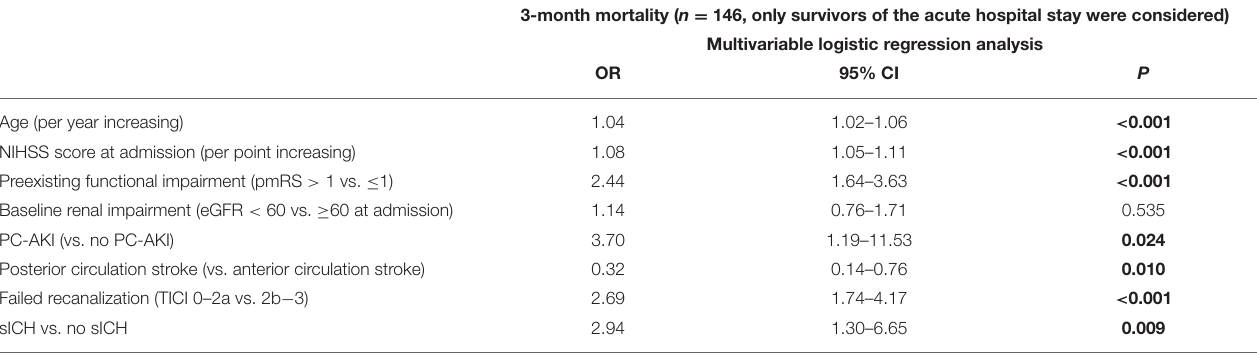
TABLE 3 | Multivariable logistic regression analysis for 3-month mortality. 3-month mortality ( n = 146, only survivors of the acute hospital stay were considered) Multivariable logistic regression analysis